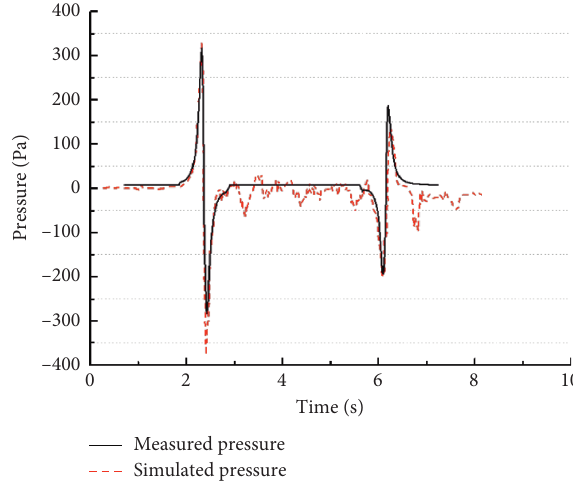
Figure 12: Comparisons of the simulated train-induced fluctuating